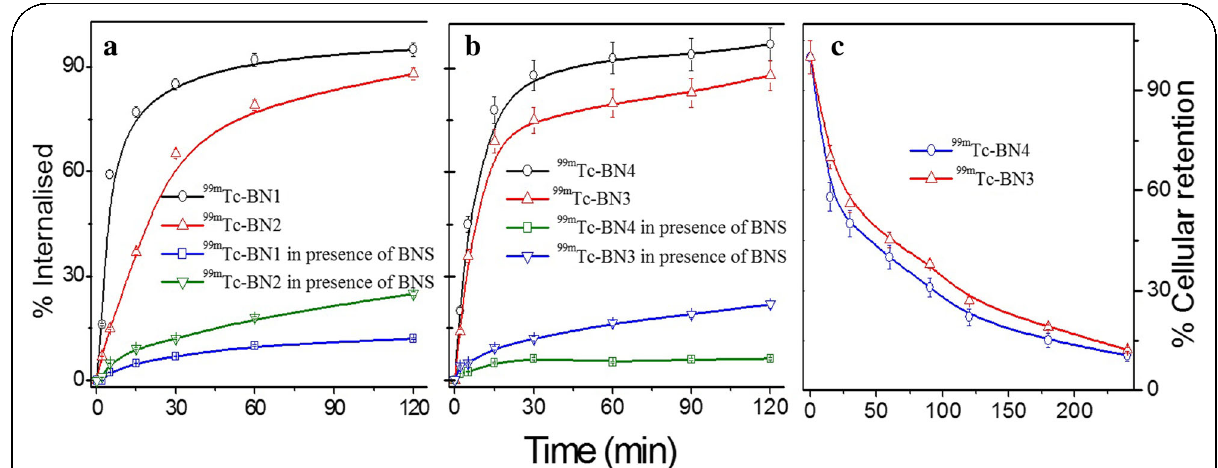
Fig. 5 Internalization of 99m Tc-BN1 and 99m Tc-BN2 ( a ); 99m Tc-BN3 and 99m Tc-BN4 ( b ) into MDA-MB-231 cells at different time intervals. Nonspecific internalization is also presented by blocking experiment in the presence of excess BNS. Externalization of 99m Tc-BN3 and 99m Tc-BN4 ( c ) from MDA-MB-231 cells at different time intervals. Temperature at 37